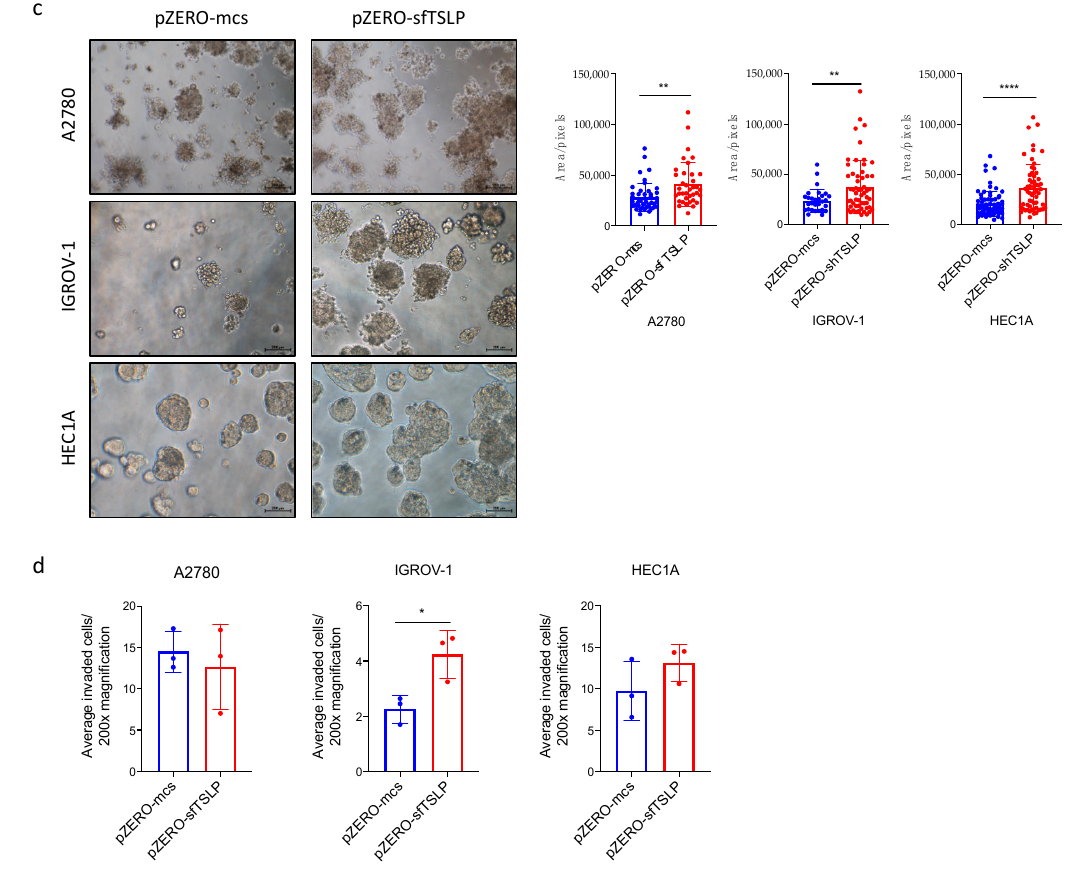
Figure 4. Overexpression of sfTSLP promoted tumour growth of ovarian and endometrial cancers in vitro. ( a ) mRNA expression of sfTSLP in human ovarian (A2780 and IGROV-1) and endometrial (HEC1A) cancer cells with stable transfection of sfTSLP-expression vector (pZERO-sfTSLP) or empty-expression vector (pZERO-mcs) was examined by qRT-PCR (TaqMan expression assay for TSLP (Hs00263639_m1)). ( b ) Cell viability of ovarian (A2780 and IGROV-1) and endometrial (HEC1A) cancer cells with sfTSLP overexpression or empty-vector expression was determined by cell viability assay after 24, 48 and 72 h incubation. ( c ) Cancer organoid formation of ovarian (A2780 and IGROV-1) and endometrial (HEC1A) cancer cells with sfTSLP overexpression or empty-vector expression was captured after a few days of incubation. Scale bar 200 µ m. ( d ) Tumour invasion ability of ovarian (A2780 and IGROV-1) and endometrial (HEC1A) cancer cells with sfTSLP overexpression or empty-vector expression was evaluated by transwell invasion assay. Data shown ( a – d ) are expressed as mean ± S.E.M. from three independent replicates (* p < 0.1, ** p < 0.01, **** p <